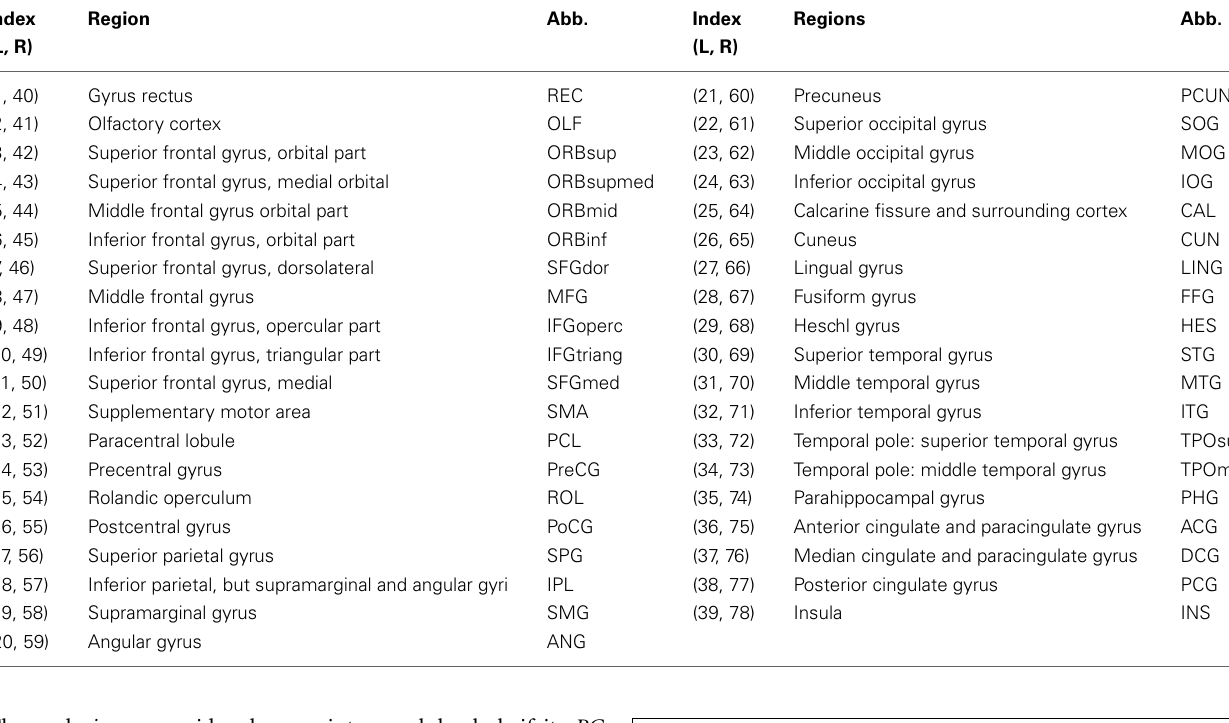
Table 2 | Seventy eight cortical regions of interest defined in the study and their abbreviations (L: left hemisphere, R: right hemisphere).